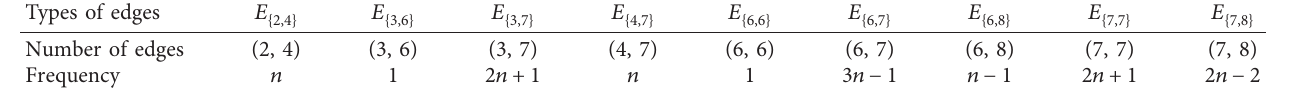
Table 2: Edge partition based on the degree sum of end vertices of each edge.